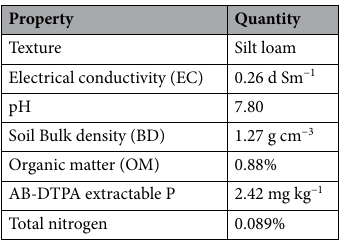
Table 4. Characterization of experimental